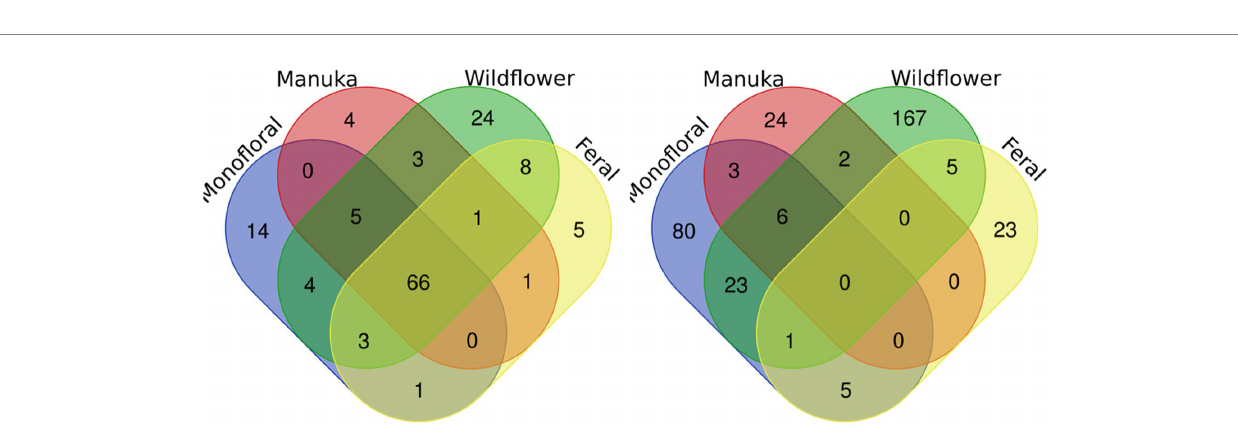
FIGURE 3 Venn diagrams for bacterial and fungal ASVs of four honey types. Bacterial and fungal ASVs were grouped based on four types of honey: monofloral, manuka, wildflower, and feral. ASVs shared between different types of honey were labeled in the overlapping area in the diagram. Left: bacterial. Right: